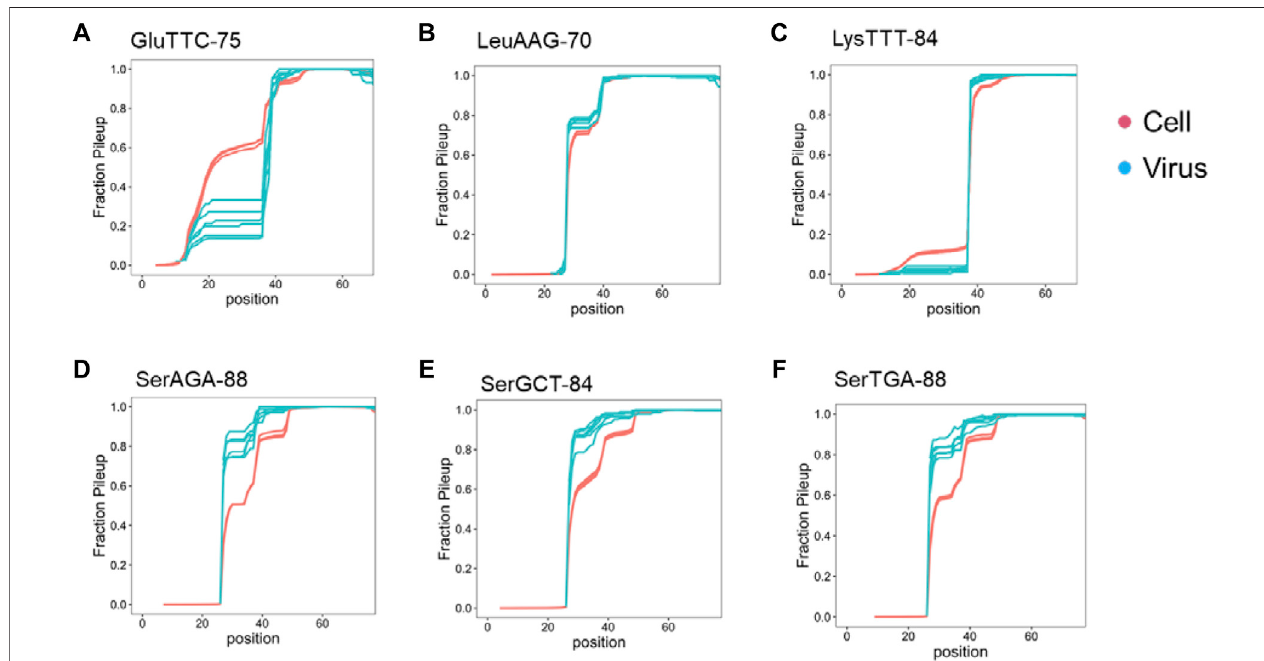
FIGURE 3 | Read pileup of the enriched tRNA isodecoder in SARS-CoV-2 viral preparations. Shown are read pileups of the most abundant tRNA isodecoders in viral isolates ( n = 6, blue) and their counterparts in uninfected Vero cell ( n = 3, red). Isodecoder nomenclature is according to the tRNAScan score of the Chlorocebus sabaeus tRNA genesidenti fi edinRfam database. (A) tRNA Glu (TTC).Thisresultisconsistent with3 ′ tRNA fragmentbeing thedominant formintheviralpreparations. (B) tRNA Leu (AAG). This result isconsistent with full-length tRNA in the viral preparations. (C) tRNA Lys (TTT). This result isconsistent with full-length or 3 ′ tRNA fragment with 5 ′ end exactly at position 39 in the viral preparations. (D) tRNA Ser (AGA). The tRNA Ser results are consistent with full-length tRNA in the viral preparations. (E) tRNA Ser (GCT). (F) tRNA Ser (TGA).